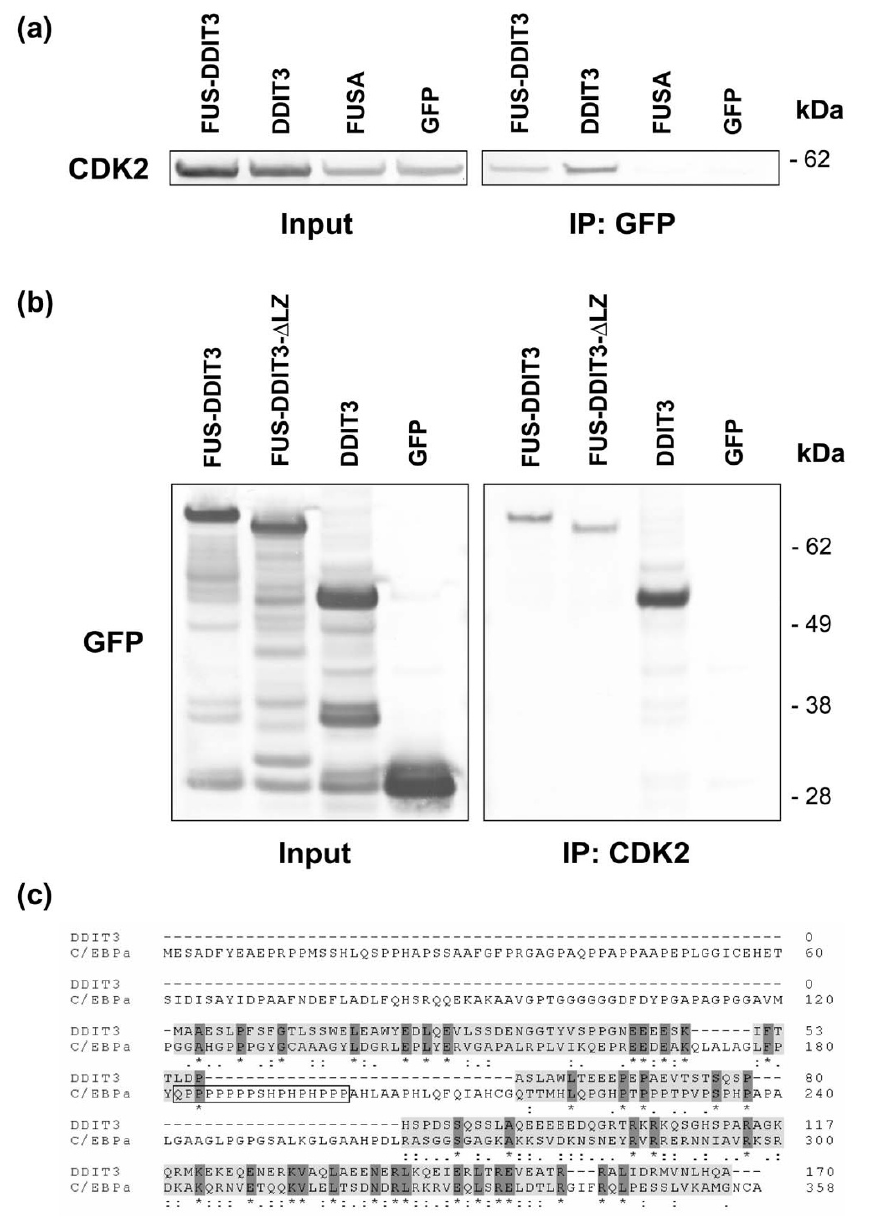
Figure 2 Co-immunoprecipitation of DDIT3 and CDK2 . (a) HT1080 cells were co-transfected with the indicated GFP constructs and CDK2-DsRed1. Proteins in cell lysates were further immunoprecipitated with anti GFP serum and recombinant CDK2- DsRed1 protein was detected by western blot using CDK2 antibodies. Input shows proteins before immunoprecipitation of cell lysates while IP shows proteins present in immunoprecipitates. (b) HT1080 cells were transiently transfected with the indi- cated GFP constructs and cellular proteins were immunoprecipitated with CDK2 antibodies. Recombinant proteins in samples were detected with anti GFP serum. The most intense bands in the input show the correct size of the GFP-tagged protein products while additional unspecific bands were also reacting with the GFP antisera in these samples. (c) ClustalW alignment of DDIT3 and C/EBP α amino acid sequences. A region shown to bind CDK2 in C/EBP α is boxed. Letters indicate standard amino acid abbreviations. Amino acids with related physicochemical characteristics are displayed below the sequences as: '*' (identical residue), ':' (highly similar residue), '.' (weakly similar residue). The leucine zipper region is seen towards the C-termi- nal in both